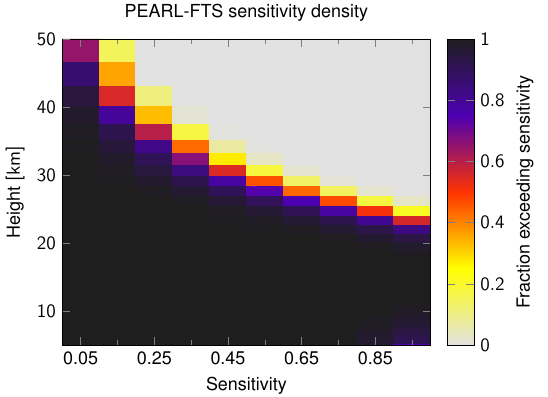
Figure 6. Sensitivity density (see Sect. 3.2) for PEARL-FTS re- trievals collocated with TANSO-FTS.